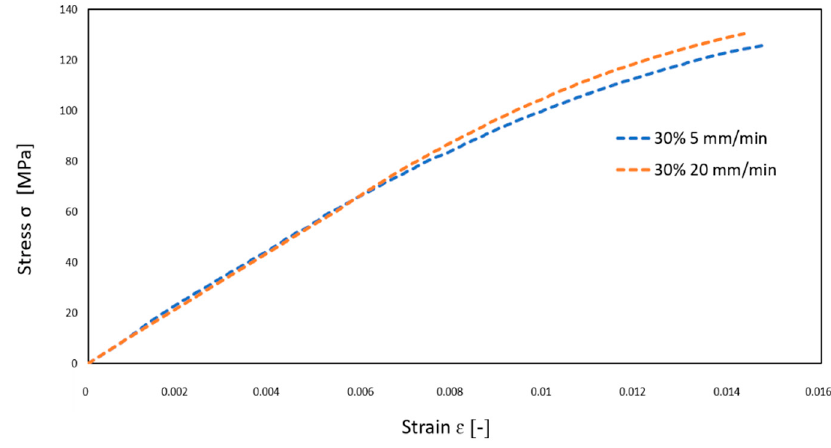
Figure 5. Conventional stress–strain diagrams of 30% GF/PBT tested at 5 and 20 mm/min.